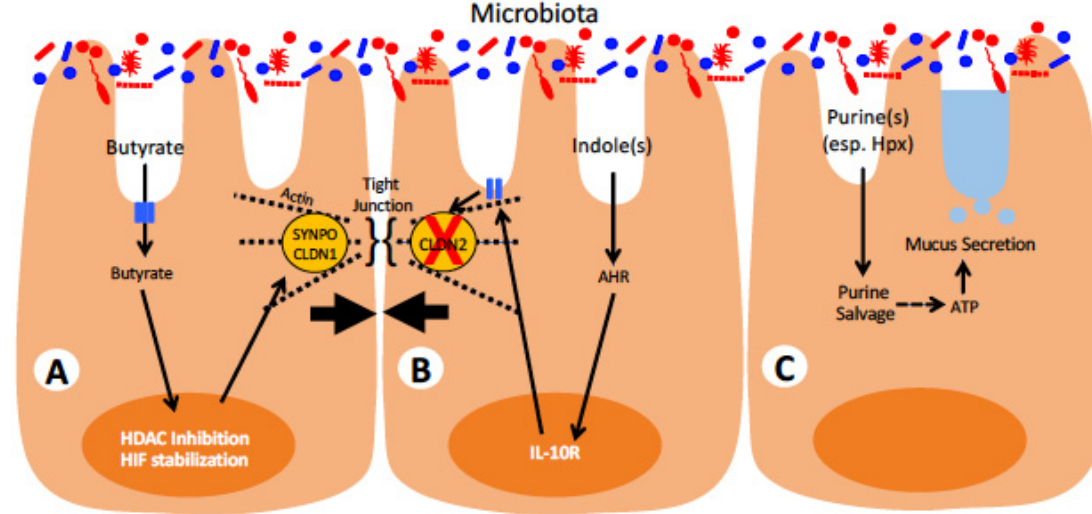
Figure 2. Microbial-derived metabolites and known functions on intestinal epithelial barrier function. Cell A depicts known response to the short-chain fatty acid butyrate. Once taken through apical membrane transporters, butyrate function as both an HDAC inhibitor and HIF stabilizer to promote expression of tight junction-associated proteins, including synaptopodin (SYNPO) and claudin-1 (CLDN1), resulting in enhanced epithelial barrier function. Cell B shows epithelial responses to the microbial tryptophan derivative indole. Once inside cells, indole(s) associate with the arylhydrocarbon receptor (AHR) to activate transcriptional induction of the interleukin-10 receptor (IL-10R), which upon activation, results in the loss of “leaky” claudin-2 (CLDN2), thereby promoting epithelial barrier function. Cell C represents the most recent observations that various microbial-derived purines (esp. hypoxanthine, Hpx) are recycled via purine salvage to be used as an energy source. Increases in intracellular ATP are associated with enhanced mucus secretion to promote enhanced epithelial barrier function.